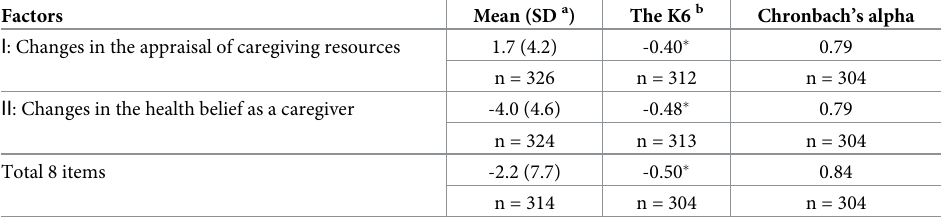
Table 5. Internal consistency and criterion-related validity of “the life change adaptation